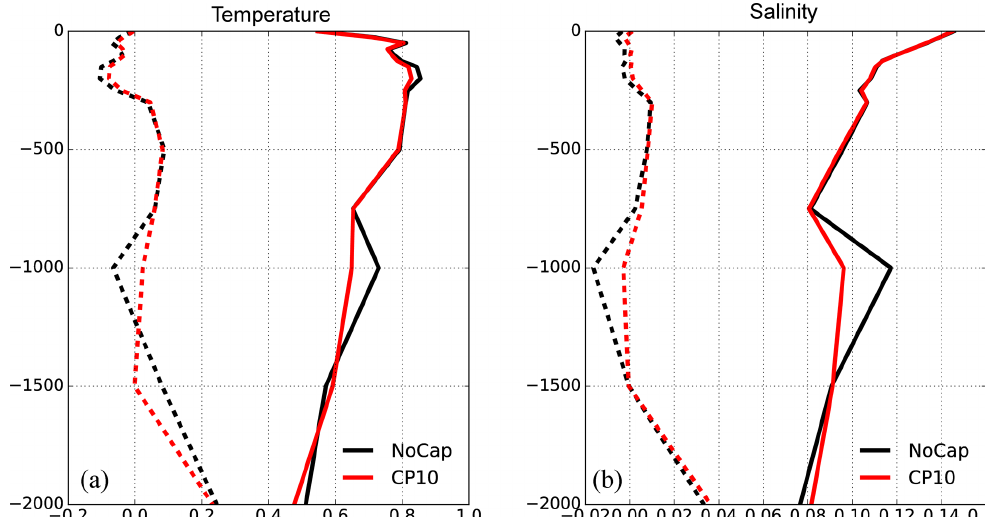
Figure 11. Profiles of model mean bias (dashed lines) and RMSE (solid lines) for (a) temperature (in K) and (b) salinity (in psu). Statistics are calculated using the model background value from NoCap (in black) and CP10 (in red), with respect to the quality-controlled EN4 data set, after averaging over the 1996–2011 period and the eastern North Atlantic